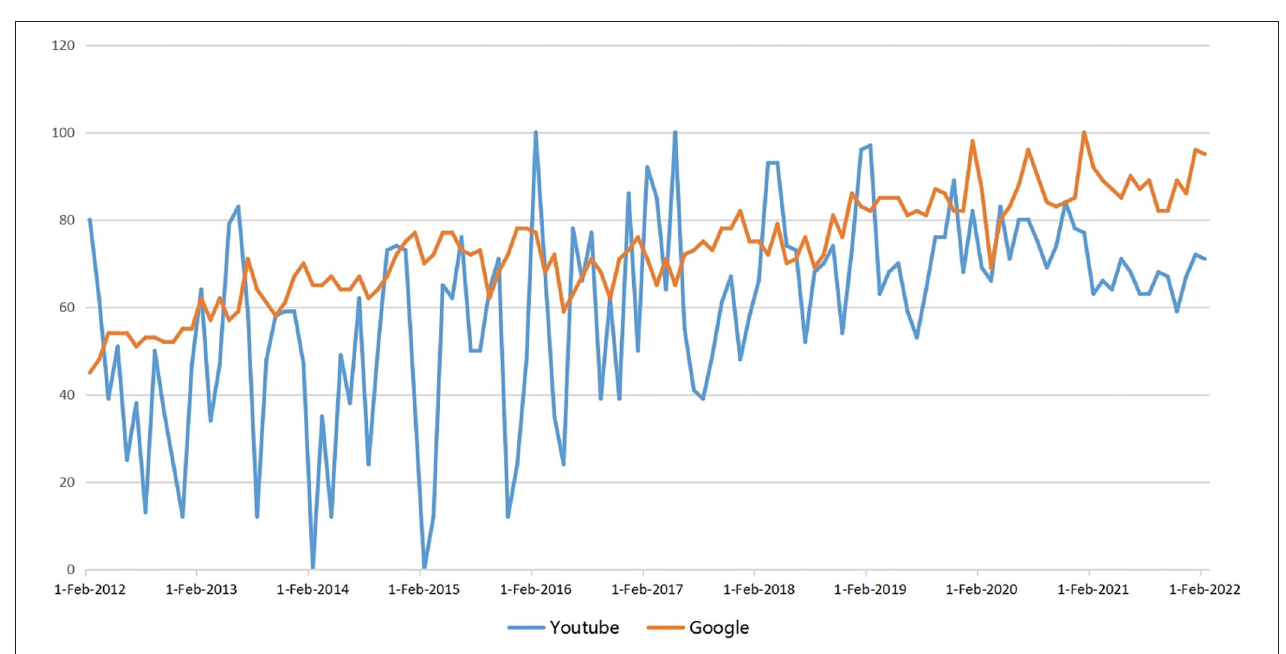
FIGURE 4 | Search trend for the term “testicular torsion” on YouTube and Google website.